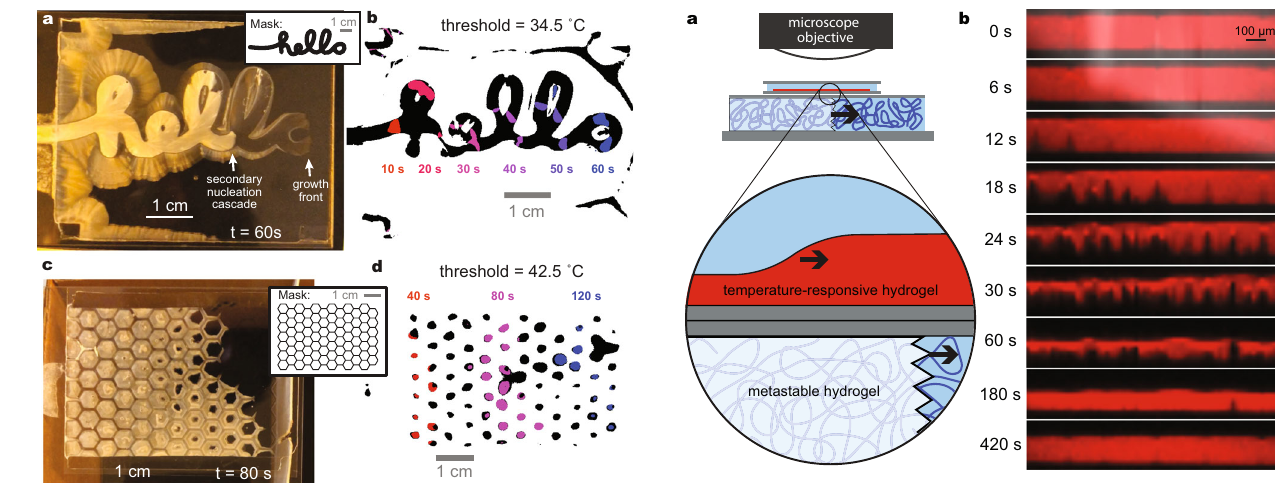
Fig. 5 Coupling of a temperature wave in crystallizing gel to a contraction wave in an adjacent thermoresponsive hydrogel fi lm. a Schematic of experiment. A confocal microscope captures Z-stacks of a fi lm of hydrated poly( N -isopropylacrylamide) bearing Nile blue acrylamide dye as sodium acetate crystallizes in a metastable hydrogel inside an underlying crystallization channel with a thickness of 2 mm. b Cross-sections of thermoresponsive gel fi lm at various timepoints show a contraction wave. Red signal shows Nile blue acrylamide fl uorescence ( λ ex = 488 nm, λ em > 492nm); white signal shows transmitted light. The transmitted light signal goes dark when crystals pass under the fi eld of view; the contraction wave trails crystal growth by ~700 µ m. Video showing XY , XZ , and YZ cross-sections available as Supplementary Movie 6; a similar experiment with a wider fi eld of view and lower magni fi cation is shown in Supplementary Movie